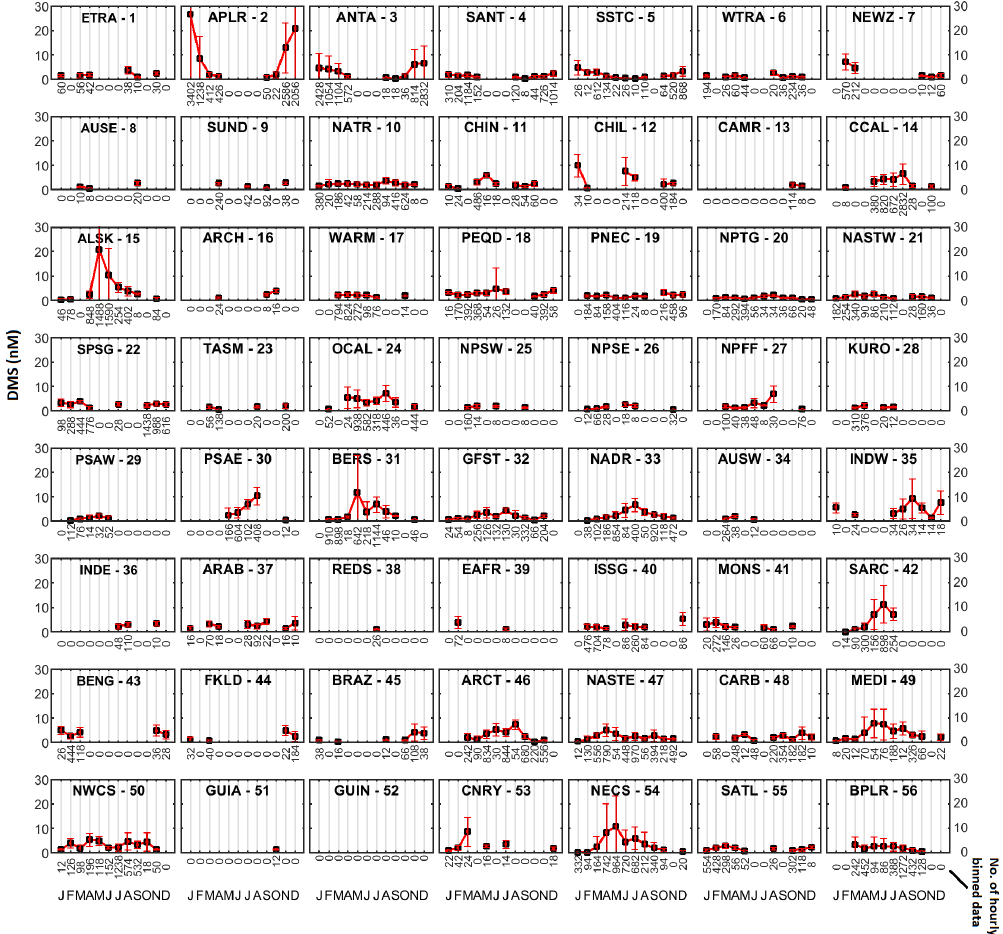
Figure 3. The data distribution in different biogeochemical provinces is different owing to the time, location, and frequency of observation. The black squares represent the monthly mean of data with standard deviations shown as error bars. The number of hourly binned observations in a month is shown below the x